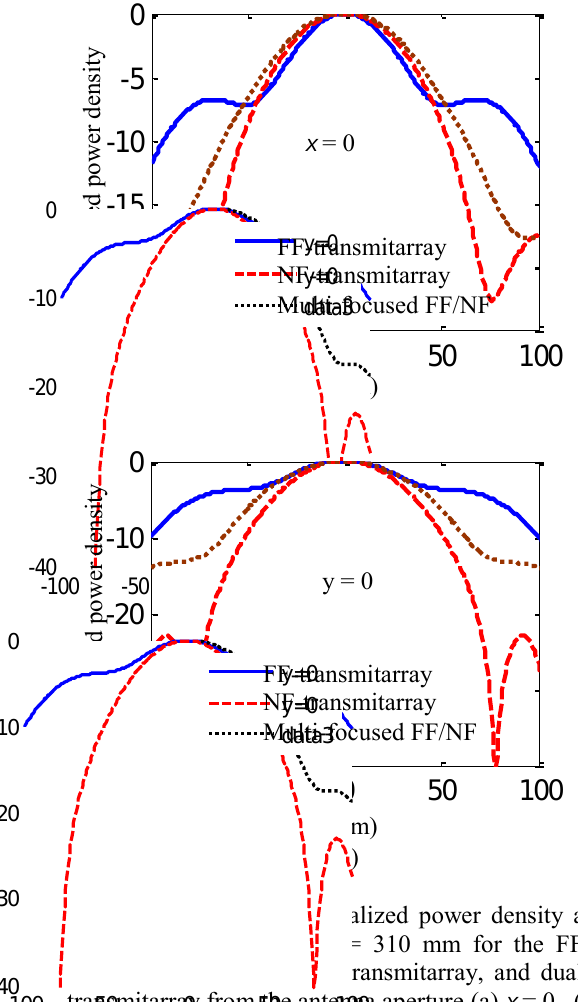
Figure 12: Simulated normalized power density along the transverse direction at R o = 310 mm for the FF-focused transmitarray, NF-focused transmitarray, and dual-focused transmitarray from the antenna aperture (a) x = 0. (b) y = 0.